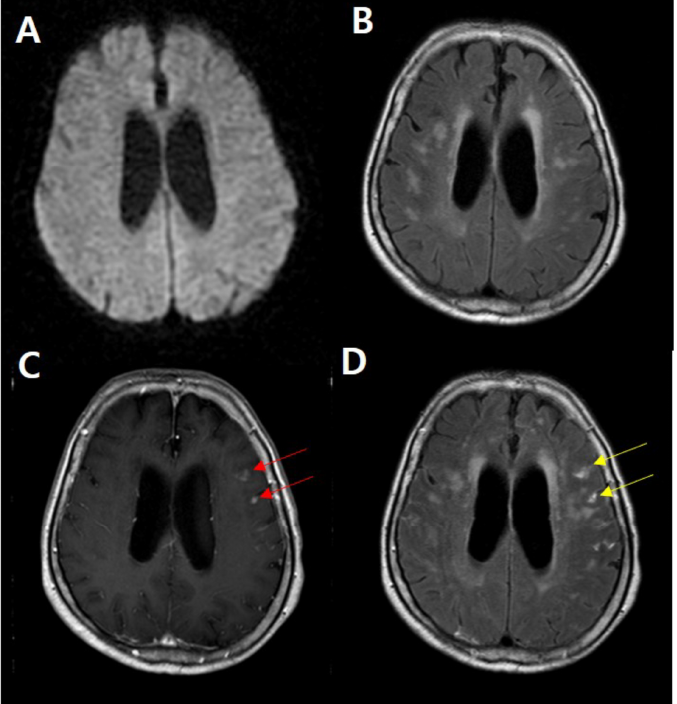
Figure 2. HARM related to subacute infarction. A 67-year-old male presented with a transient language problem and right arm weakness with preceding thunderclap headache, approximated 10 days. Initial DWI ( A ) showing no diffusion restriction lesion in the brain. Postcontrast T1WI ( C ) showing two nodular enhancements at the left frontal cortex (red arrow). Postcontrast FLAIR image ( D ) showing the typical HARM (yellow arrow), which is well-visualized compared with the non-enhanced FLAIR ( B ).